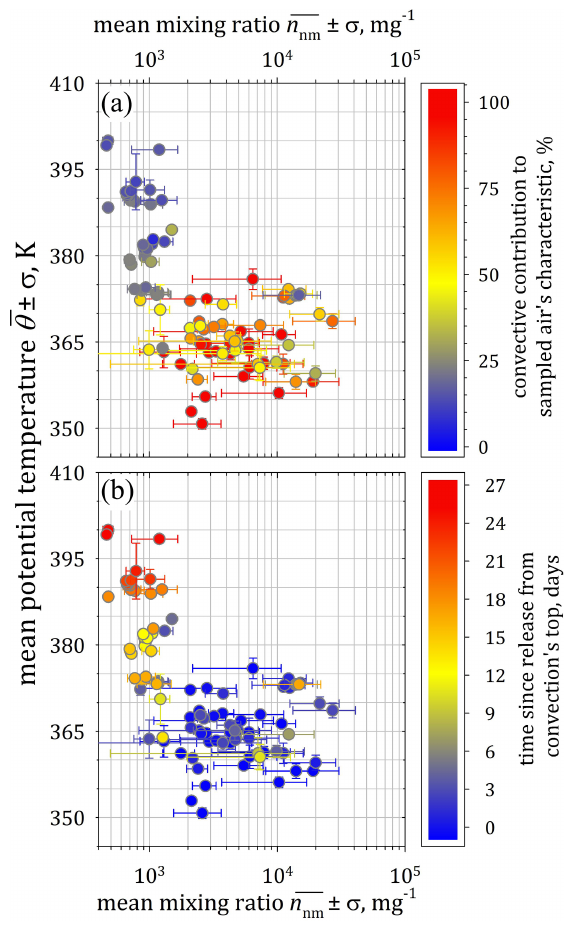
Figure 12. Vertical profile of the event-wise mean particle mixing ratio of nucleation-mode particles n nm with standard deviation σ (bars) as a function of the mean potential temperature ( ± σ ). (a) The data points are colour-coded by the proportion of convective contri- bution to the air sample. (b) The data points are coloured by the time (days) since the release of the air mass at the top of a convective